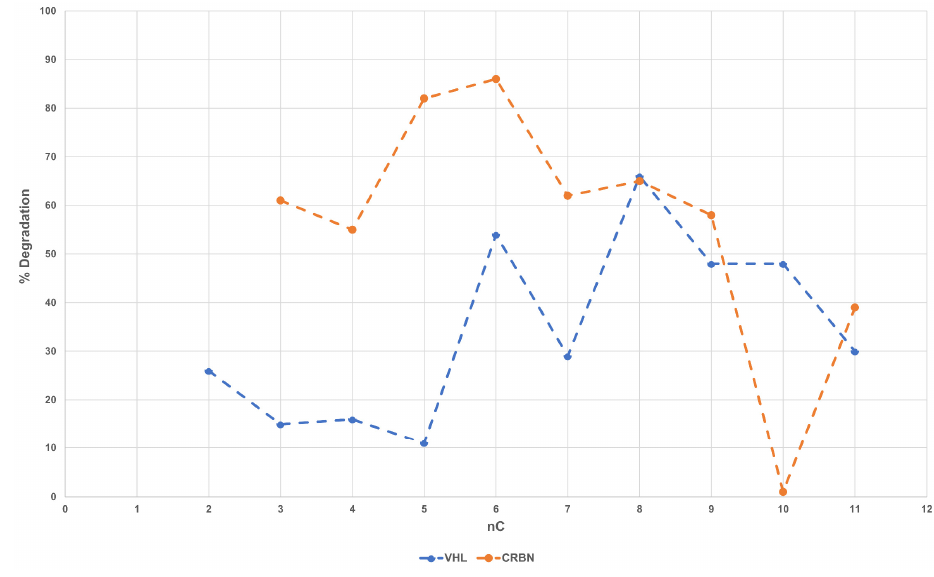
Figure 4. Degradation 0.1 µ M vs. number of carbon atoms in the linker.